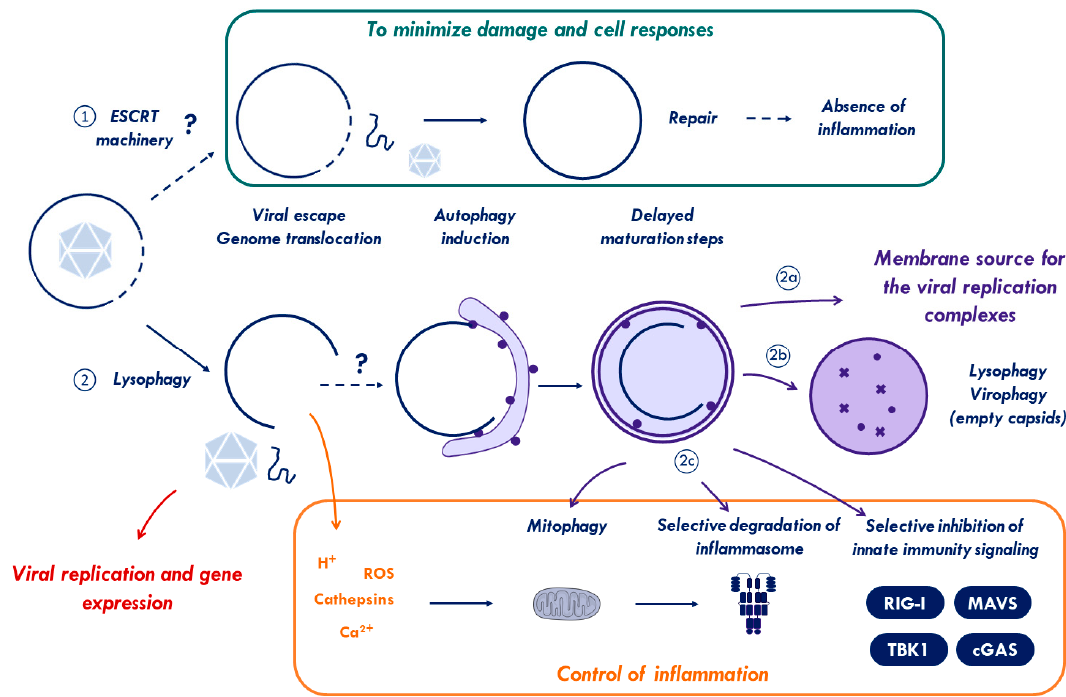
Figure 5. Model for non-enveloped virus membrane penetration. Non-enveloped viruses breach endo-lysosomal membranes for particle escape into the cytosol or cytosolic genome translocation. (1) If the membrane damage is small enough, Ca 2 + -dependent recruitment of the ESCRT machinery will repair the endosomes limiting time and extend of the damage. This strategy could provide enough time for the virus / genome to reach the cytosol without activating the inflammatory pathways. (2) If this repair fails or the inflicted damage is too large, “eat-me signals” (galectins and ubiquitin) will accumulate at the damage site and initiate autophagy. Viruses use viral factors (e.g., Ad) or cellular factors (e.g., PV) to delay the autophagy response until capsids / viral genomes reach the safety of the cytosol. The ensuing autophagy response than may continue and work in favor of the virus. Activating autophagy via membrane damage could (2a) provide a membranes source for viral replication, and (2b) remove and recycle membrane remnants, damaged lysosomes, and empty viral capsids to avoid excessive cells responses. Additionally, autophagy could (2c) limit excessive inflammation through autophagic degradation of damaged mitochondria and by removing activated inflammasomes and e ff ectors of the innate immunity signaling pathways (see text for details).